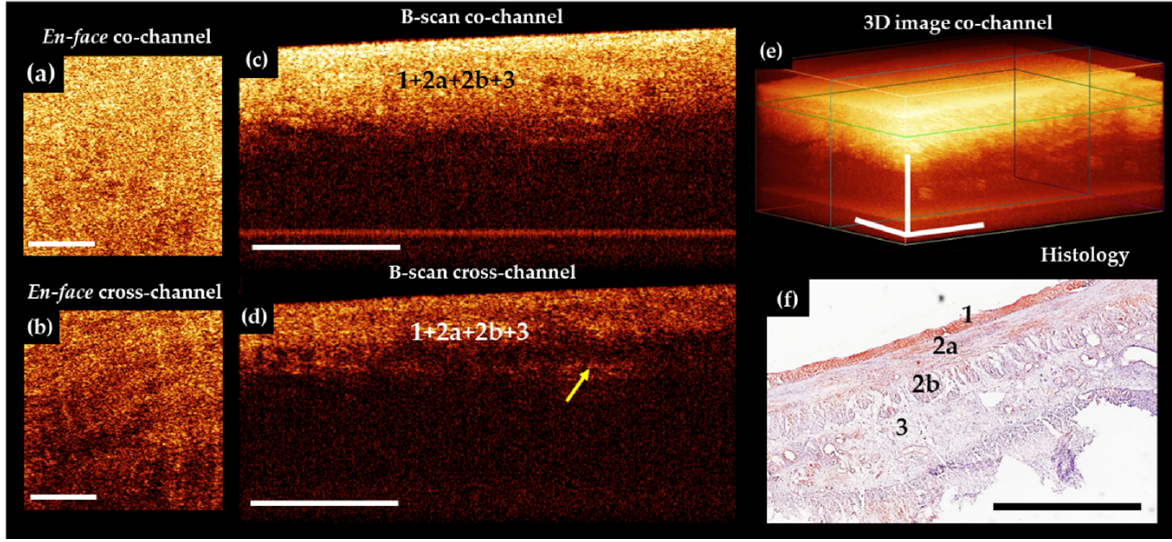
Figure 5. Representative trans-serosal CP OCT images of ileum with transmural ischemic necrosis. In the B-scans co– ( c ) and cross– ( d ) channels and in 3D OCT image ( e ) the depth of tissue visualization is decreased significantly and individual layers of the serous membrane (1), outer longitudinal muscular layer (2a), and inner circular muscular layer (2b) are not distinguishable due to the developed necrosis in all layers of the intestinal wall ( f ). In the B-scans cross-channel ( d ) in the lower part of the inner muscle layer, the signal is noticeably reduced, and the transition from this layer to underlying tissue of the submucosa (3) can be detected. ( a , b ) En-face OCT images at the level of the longitudinal muscle layer (green horizontal line in ( e )), demarcated from the surrounding tissue fluid accumulation is not observed. ( f ) Corresponding histological image, H&E staining. Scale bars 1 mm.